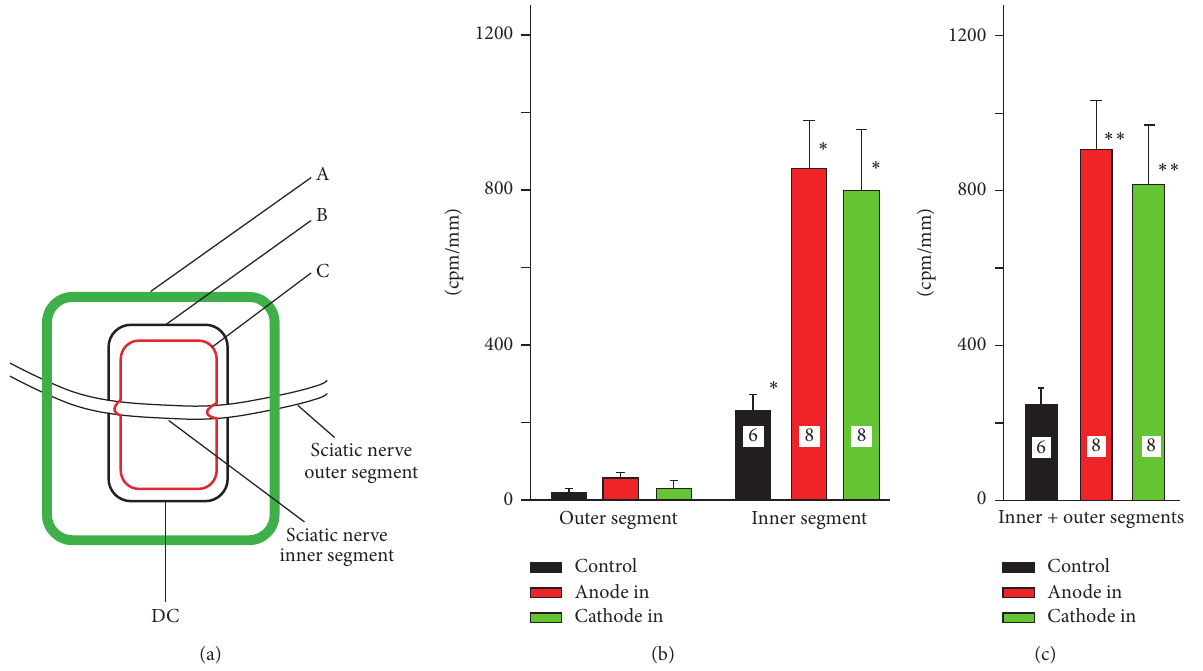
Figure 1: The accumulation of 45 Ca 2+ by DC-stimulated sciatic nerve in vivo; (a) an experimental set up. The exposed segment of the sciatic nerve was surrounded by the barrier made of hydrophobic petroleum jelly/silicone oil mixture which formed the external pool (A). The second smaller (internal) pool (B) was made of the same petroleum jelly on the stimulation plate (C) inserted underneath the sciatic nerve. The stimulation plate (15 × 20 mm) was insulated from the tissue by the rectangular piece of the rubber located under the stimulation plate (omitted for the clarity from the picture). This experimental arrangement allowed keeping outer and inner segments of the sciatic nerve in different chambers which were electrically isolated from each other except for the connection made by the nerve itself. (b) 45 Ca 2+ accumulated in the inner and outer segments (cpm/mm) in control experiments (no stimulation, black), and when either anode (red) or cathode (green) was connected to the stimulation plate ( ∗ 𝑝 < 0.001 , one-way ANOVA followed by Dunn’s test). (c) The total accumulation of 45 Ca 2+ in inner and outer segments ( ∗∗ 𝑝 < 0.001 , Mann–Whitney U Sum Rank test, control versus “anode in” and “cathode in” for combined segments). In this legend and all subsequent figure legends, the numbers inside of the bars indicate the number of separate